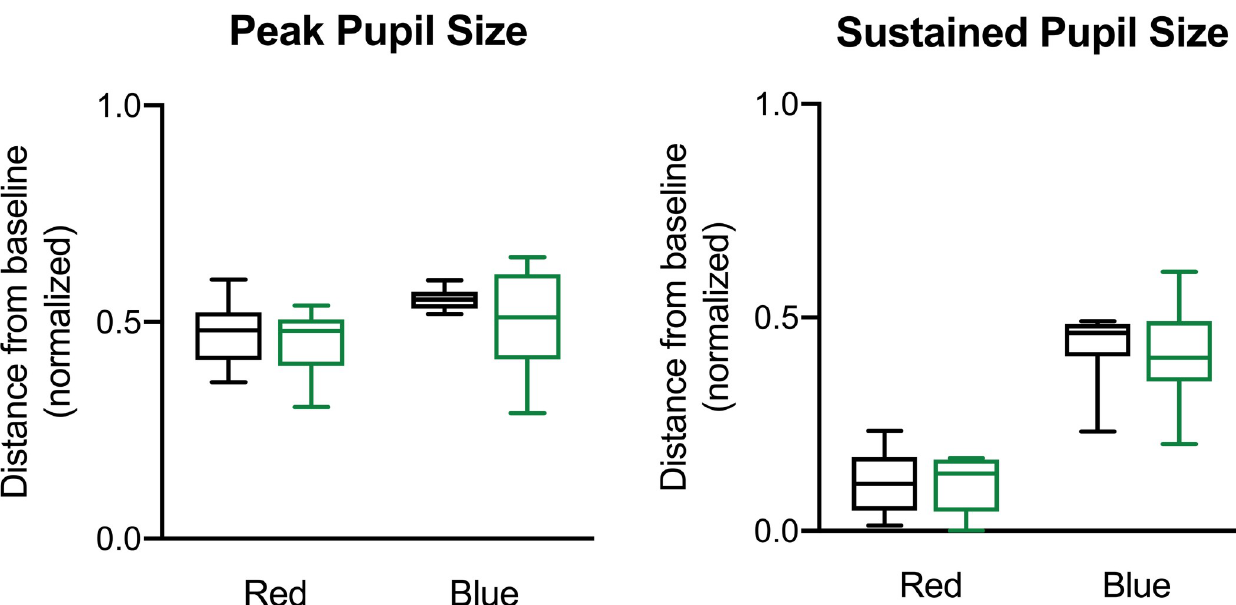
Fig 2. Pupillometry measurements in pre-AD and controls. Box whisker plots are shown comparing the pupillary light response following the red (620 nm) and blue stimulus (450 nm) for controls (black) and pre-AD participants (green). (A) Normalized peak pupil size and (B) normalized sustained pupil response as a change from baseline pupil size. Peak pupil size was defined as normalized pupil size at point of maximum pupil constriction or minimum pupil size. Sustained response was defined as the median normalized pupil size in the time window between 6 to 8 seconds from flash onset. Pre-AD, pre- symptomatic Alzheimer’s